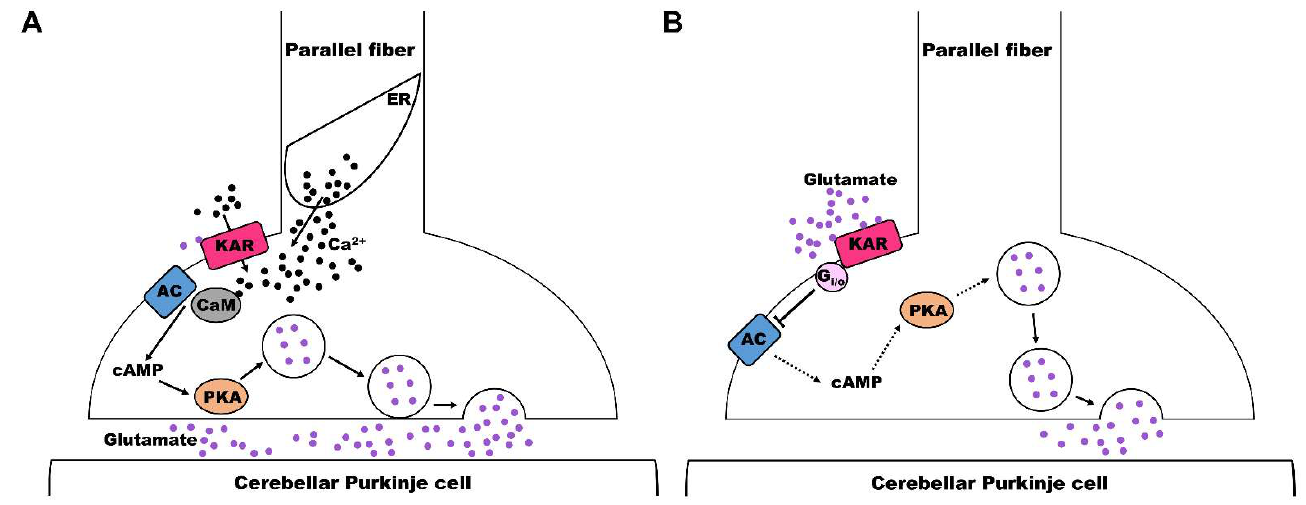
Figure 5. Schematic diagram of KAR-mediated facilitation or depression of glutamate release at PF– PC synapses of cerebellum. ( A ) The proposed mechanism of KAR-mediated facilitation of glutamate release at PF–PC synapses of cerebellum. Low concentration of KA enhances glutamate release through the activation of Ca 2+ permeable KARs and the induction of Ca 2+ from the internal reserves in endoplasmic reticulum (ER). The increase in cytosolic Ca 2+ mediates the formation of Ca 2+ -CaM to activate AC/cAMP/PKA signaling. ( B ) The proposed mechanism of KAR-mediated depression of glutamate release at PF–PC synapses in cerebellum. High concentration of KA inhibits glutamate release via activating KARs then activating G protein and modifying AC and PKA activity.